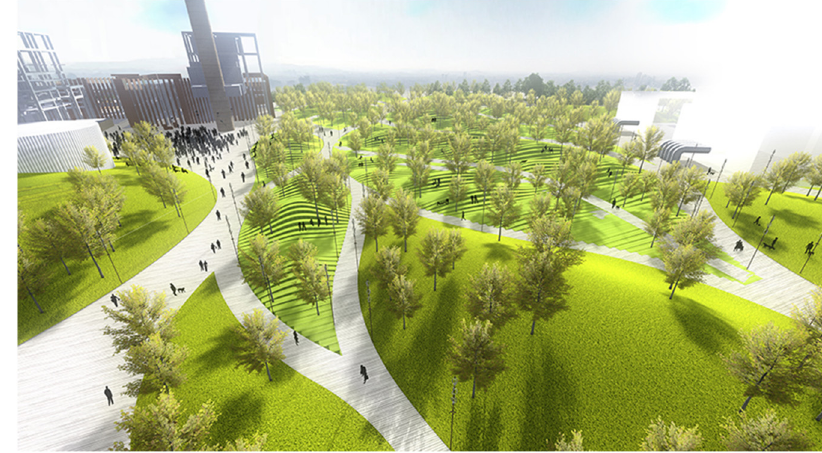
Figure 8. Bird eye’s view of mud infrastructure (source: author’s photograph).